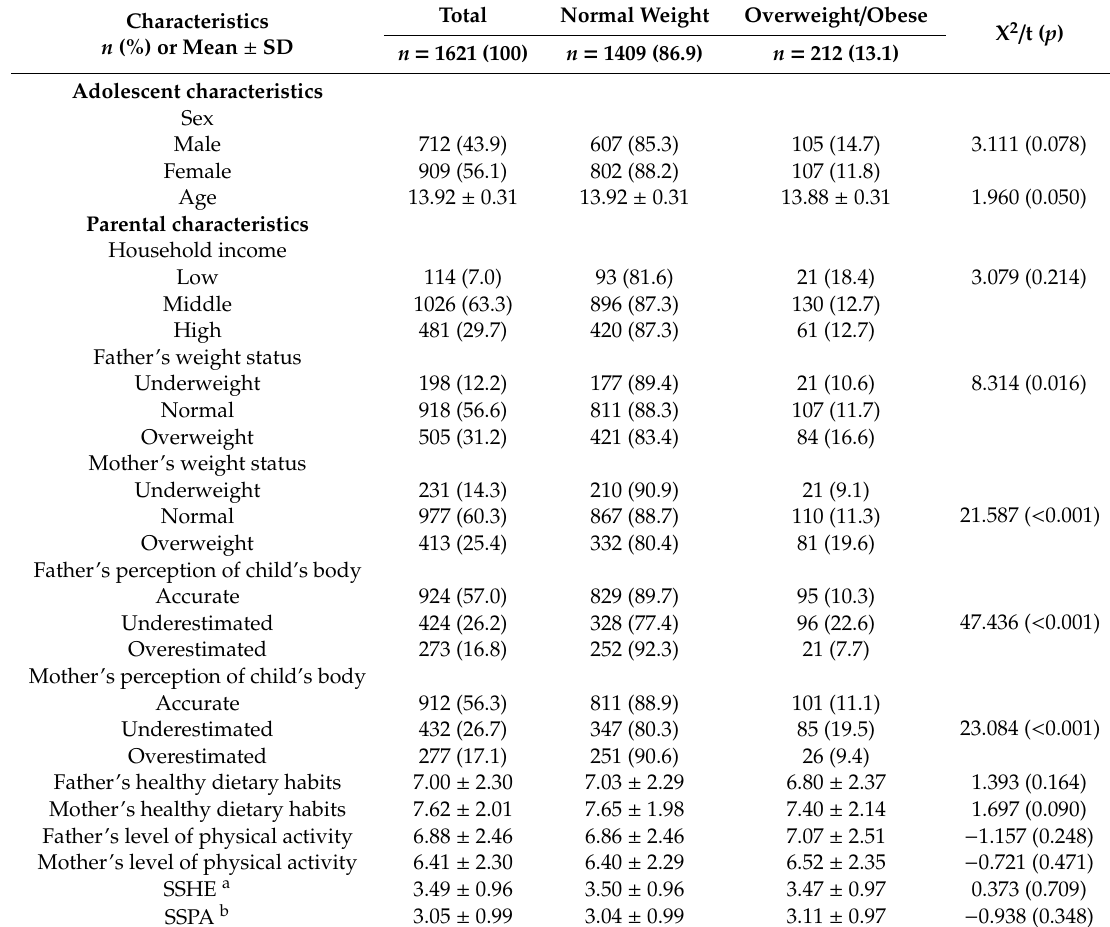
Table 1. Overweight / obese status according to adolescent and parental characteristics ( n = 1621).